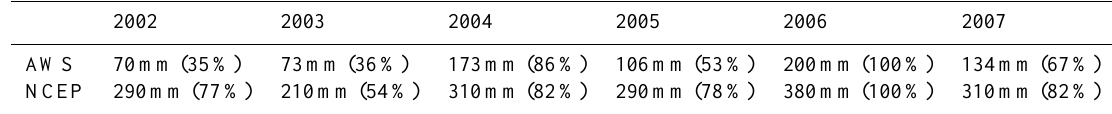
Table 1. Cumulative rainfall of the AWS and NCEP, shown in millimeters and as a percentage of 2006 total.